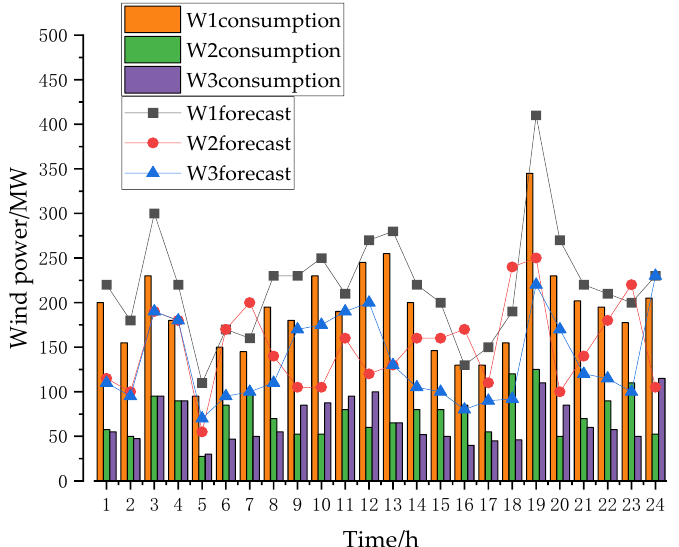
Figure 9. Wind farm accommodation in Case 2.